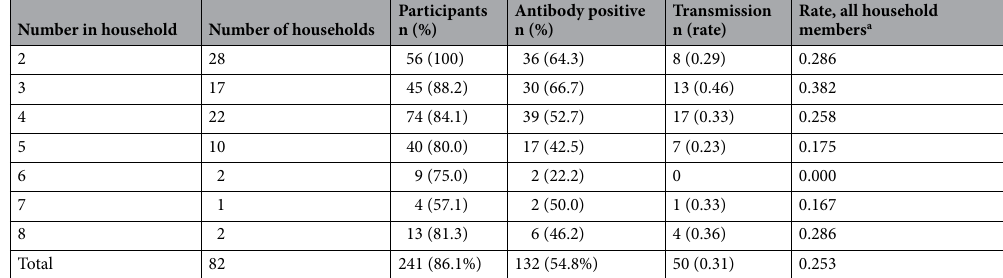
Table 5. Household transmission rate by household size. a Assuming the members who did not participate were not positive.